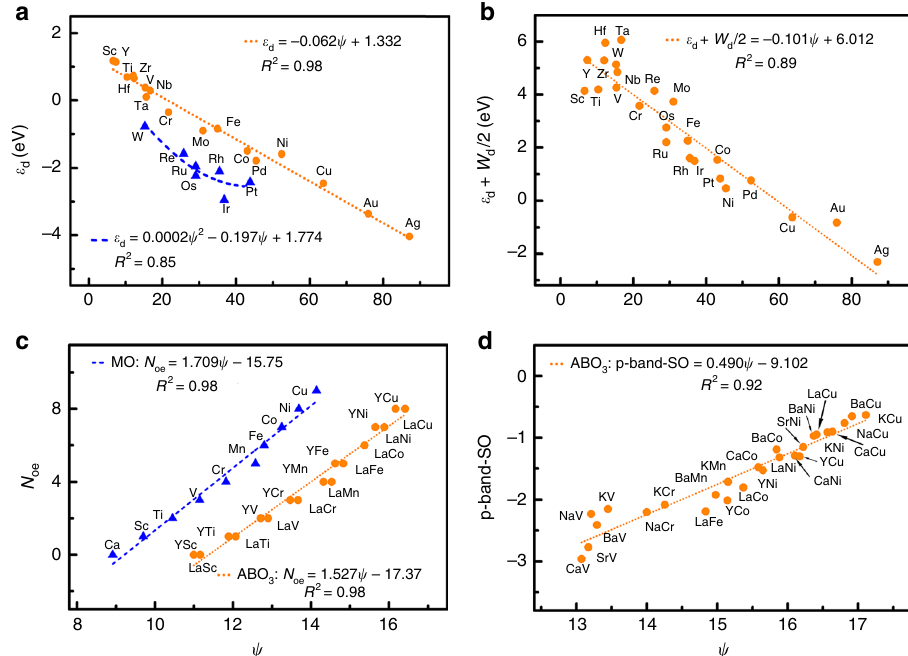
Fig. 6 Comparison between the electronic descriptor ψ and the previous models on transition metals (TMs) and oxides. a The d -band center ε d of the semi-elliptical distribution of density of state (DOS) vs. the electronic descriptor ψ 10 . The ε d of seventeen TMs is linearly correlated with ψ , whereas the ε d of the other seven TMs exhibits a quadratic relation with ψ . b The upper edge of the d -states of DFT DOS (namely d -band center with a half of d -band width, ε d + W ψ for the twenty-four TMs 10 . The ε + W ψ . c The number of outer d /2) vs. the electronic descriptor d d /2 of the twenty-four TMs is linearly correlated with electrons N oe vs. the electronic descriptor ψ for monoxides (MO) and perovskite oxides (ABO 3 ) 37 . For both MO and ABO 3 , the N oe is linearly correlated with ψ . d The p -band center of surface oxygen ( p -band-SO) vs. the electronic descriptor ψ for ABO 3 49 . The p -band-SO of ABO 3 shows a linear relation with ψ . The substrate name, the color code, and the fi ts are provided as insets. Source data are provided as a Source Data fi